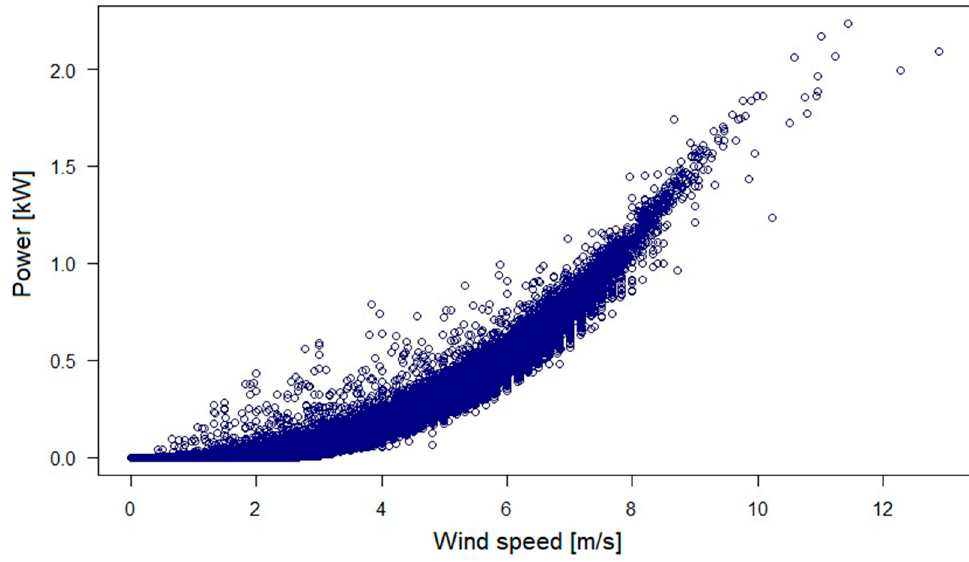
Figure 17. Small Wind Turbine 1-min average power (from 2018–2020).